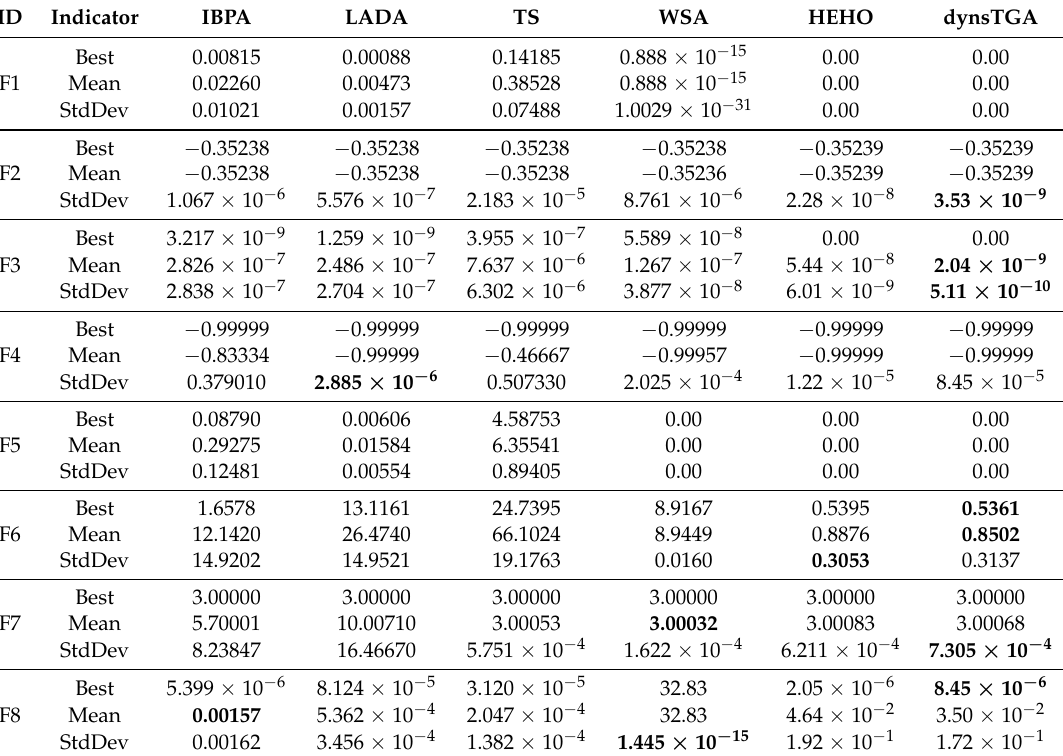
Table 4. Comparative analysis—HEHO and dynsTGA vs. other metaheuristics for unconstrained benchmarks. (best results for each performance indicator are marked